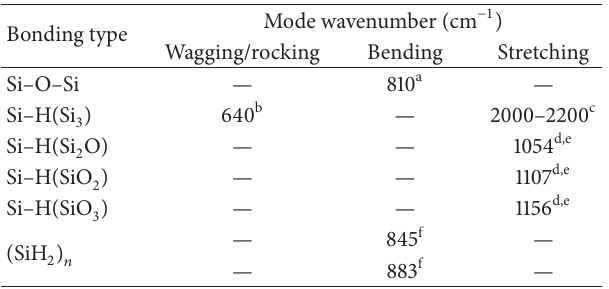
Table 2: Bonding types/modes and corresponding wavenumbers investigated by FTIR in this